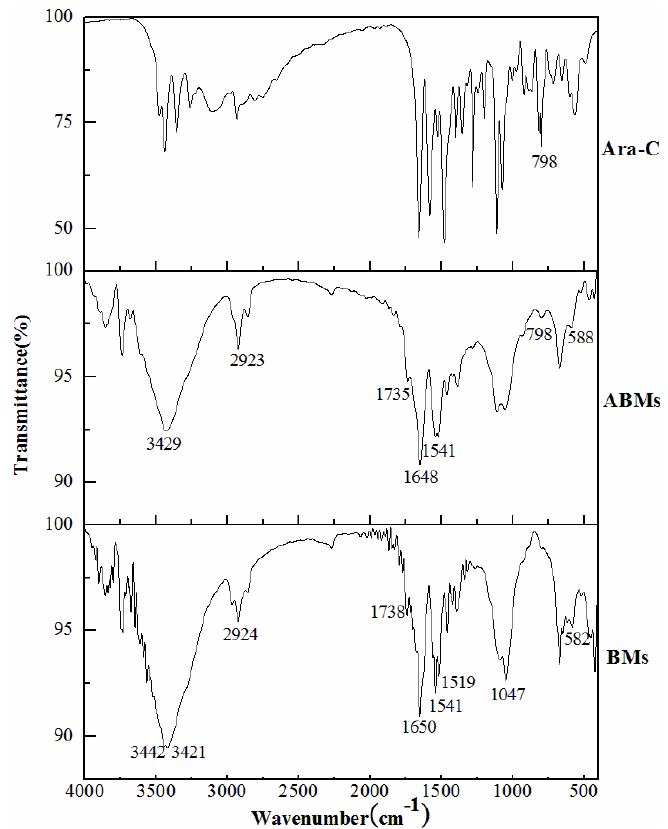
Figure 2. The FTIR spectra of Ara-C, ABMs and